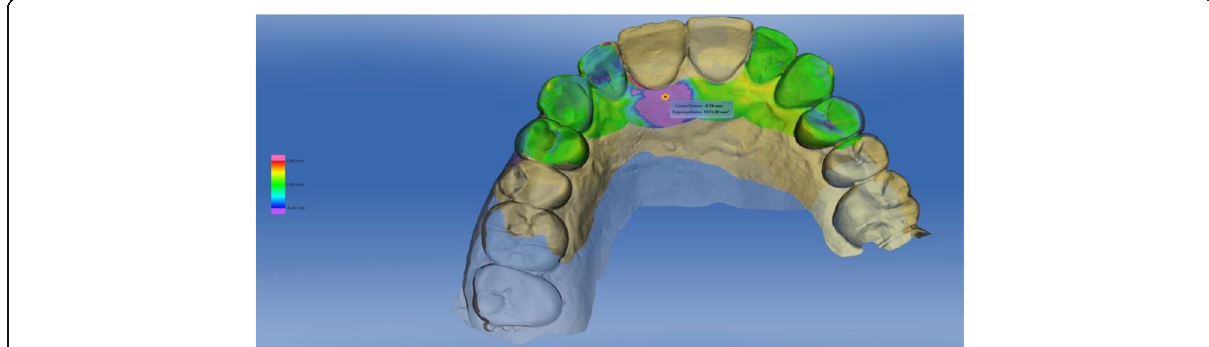
Fig. 20 Colour-coded superimposition of intraoral scans before extraction and after definitive prosthetic